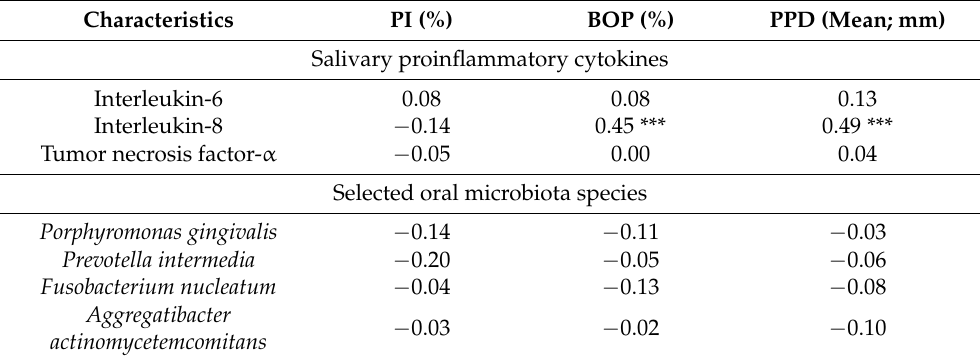
Table 1. The relationship of baseline clinical parameters with salivary proinflammatory cytokines and representative bacterial species in the oral microbiota of patients ( n = 72) with periodontal disease. Characteristics PI (%) BOP (%) PPD (Mean; mm) Salivary proinflammatory cytokines Interleukin-6 0.08 0.08 0.13 − 0.14 Tumor necrosis factor- α − 0.05 0.00 0.04 Selected oral microbiota species − 0.14 − 0.11 − 0.03